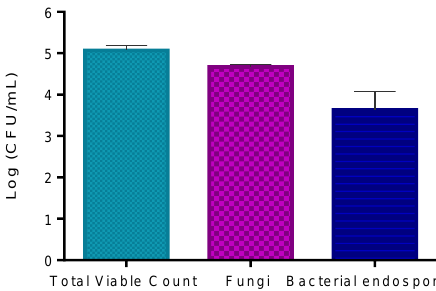
Figure 5. Quantification of natural microorganisms on trade pollen: total viable count, fungi, and bacterial endospores. Values represent the mean of three experiments; error bars represent the standard deviation.